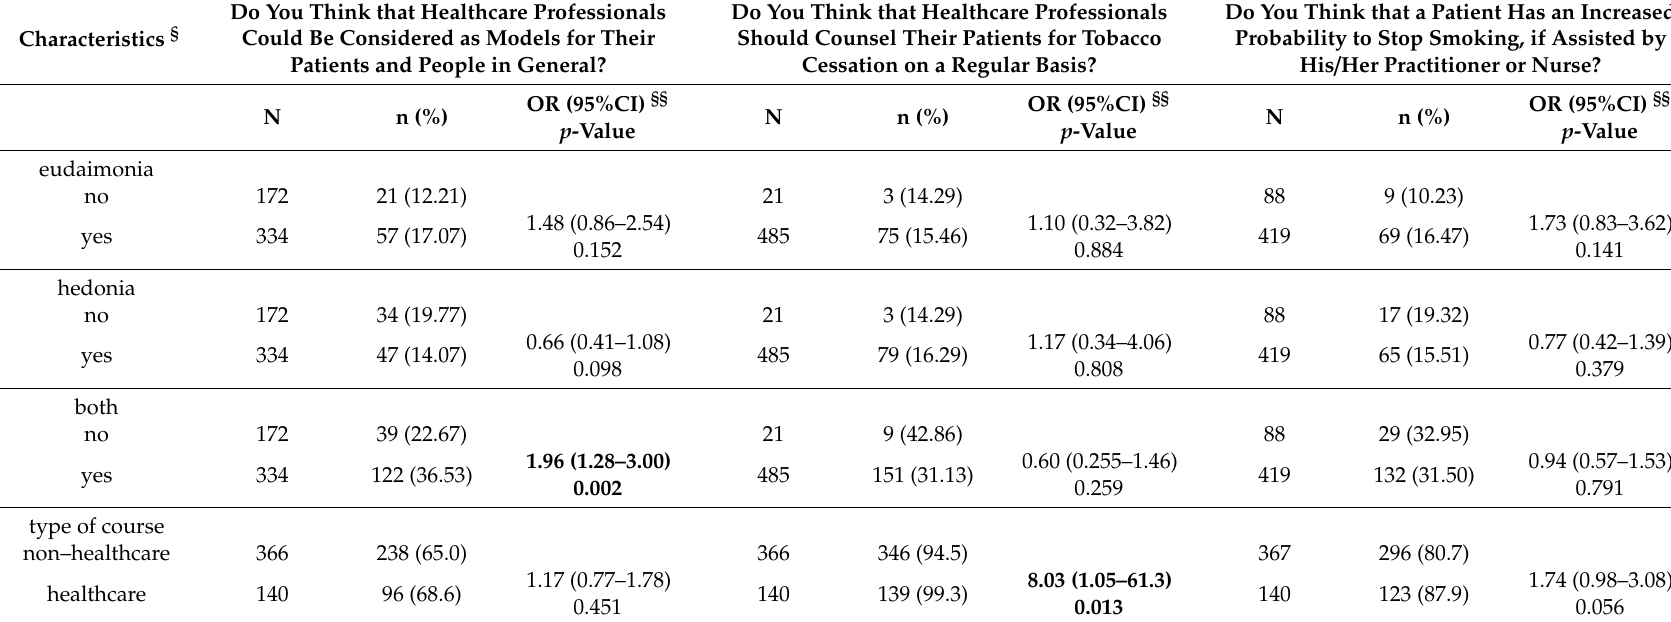
Table 3. Role of healthcare professionals for prevention and health promotion using a well–being approach and type of course in a sample of 508 undergraduates of University of